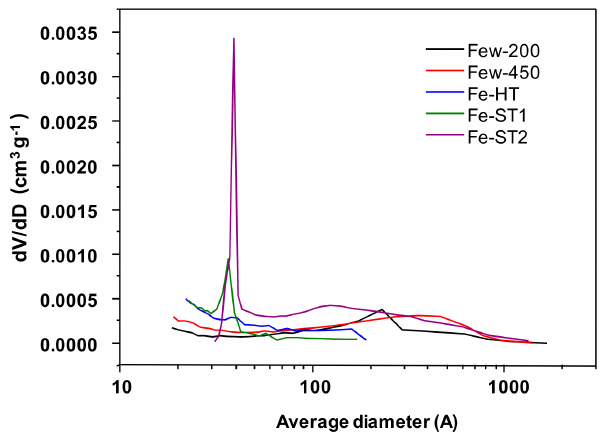
Figure 4. Pore-size distributions for the prepared catalysts.